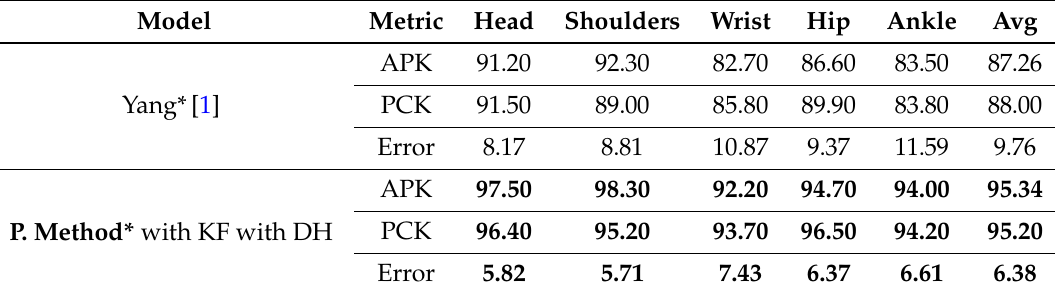
Table 1. Experimental comparisons with the state-of-the-art methods on our proposed data set. The probability of a correct kypoint (PCK) and the average precision keypoint (APK) metrics are expressed on %. Error is expressed in